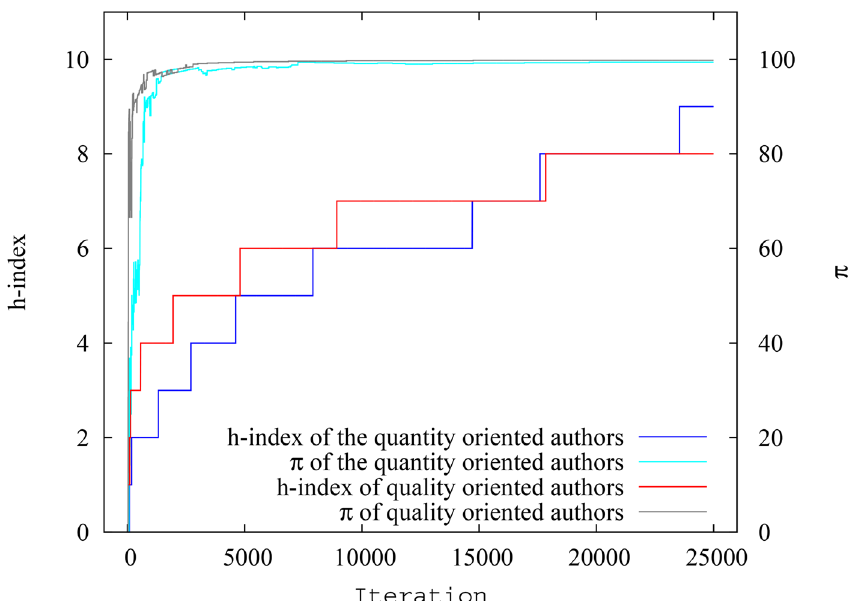
Fig 14. Variation of h-index and pagerank-index for highest ranking quality oriented authors and quantity oriented authors at each timestep in scenario 3. The difference between the highest ranking authors is much smaller when pagerank-index is